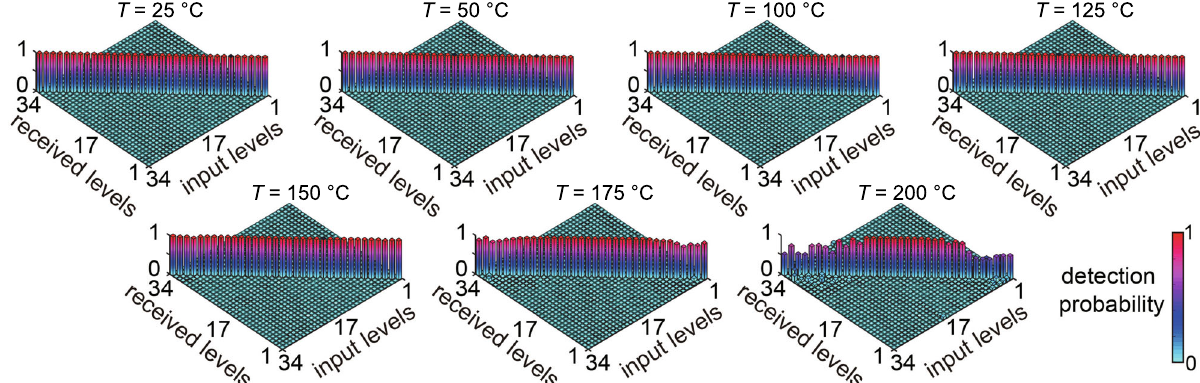
Fig. 7 Experimentally obtained detection probability matrices. The experimentally measured detection probability matrix for the transmitted and received information levels at different turbulence strengths. The horizontal axes denote the encoded and received information levels, and the color indicates the value of the detection probability between 0 and 1.